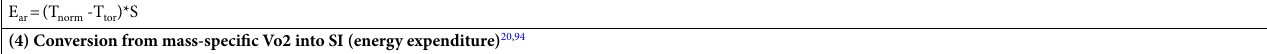
Table 3. Bioenergetic modeling to estimate the theoretical energy expenditure of reproductive female bats using the Classic and Ncube PH1 bat